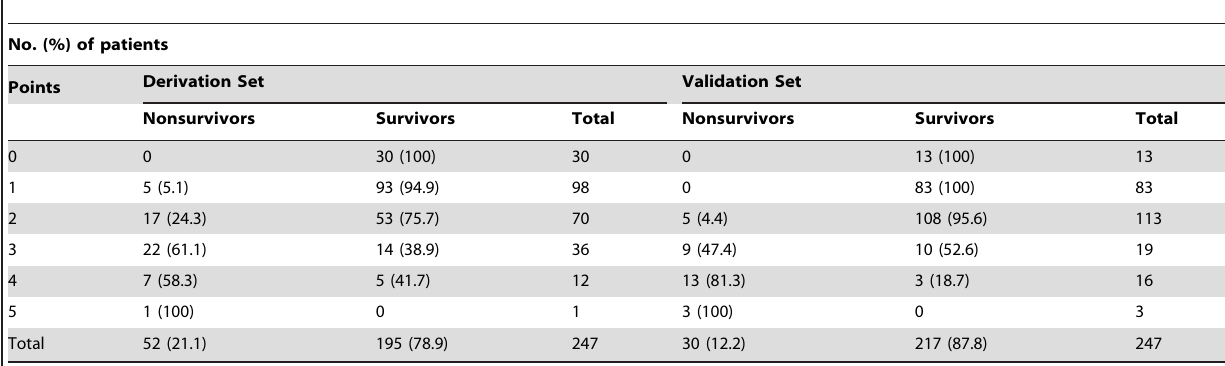
Table 3. Distribution of scores in the derivation and validation